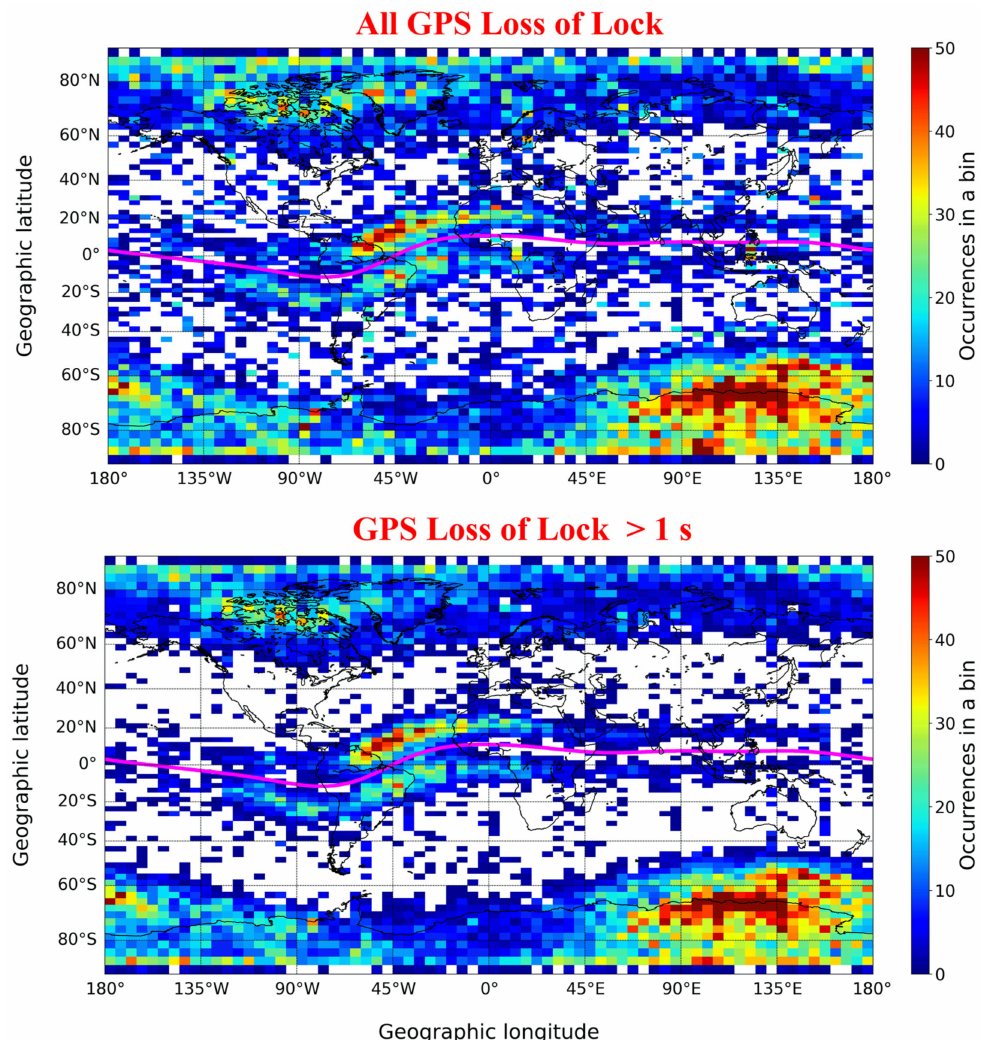
Figure 3. Geographic distribution of the GPS LoL occurrence affecting Swarm A, B, and C, from December 2013 to December 2020, considering ( top panel ) all LoL events, independently of the duration, and ( bottom panel ) considering only those events whose duration is greater than 1 s. The magenta curve visible in both panels represents the magnetic